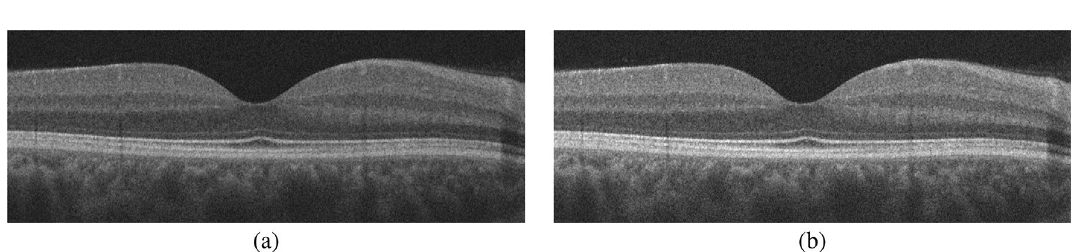
Figure 5. OCT scan normalization: ( a ) original image, and ( b ) normalized